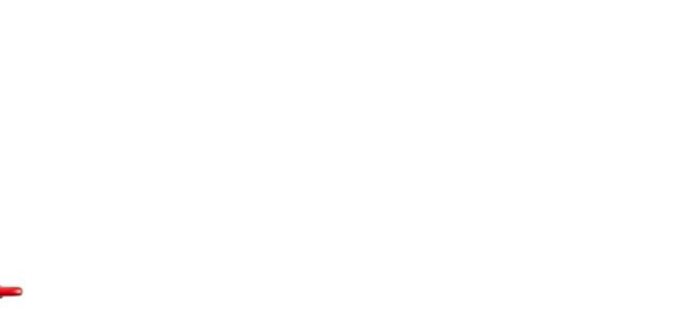
Figure 2. Leica Pegasus: Two Ultimate vehicle-mounted system. Photo courtesy of Leica Geosys- tems